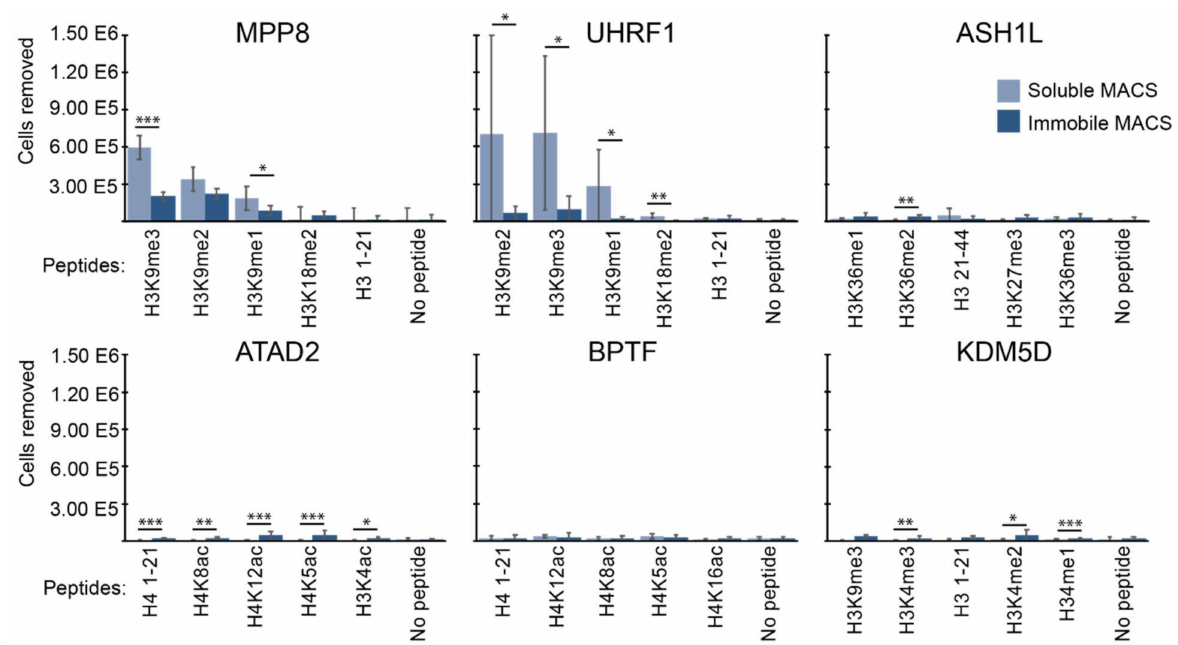
Figure 6. Soluble peptide binding followed by immobilization improves yield. The number of protein-displaying cells pulled down in classic versus soluble MACS methods as a function of histone peptide; error bars represent the standard deviation of triplicate pulldowns; * p < 0.1, ** p < 0.05, *** p < 0.01; p -values calculated via single-factor